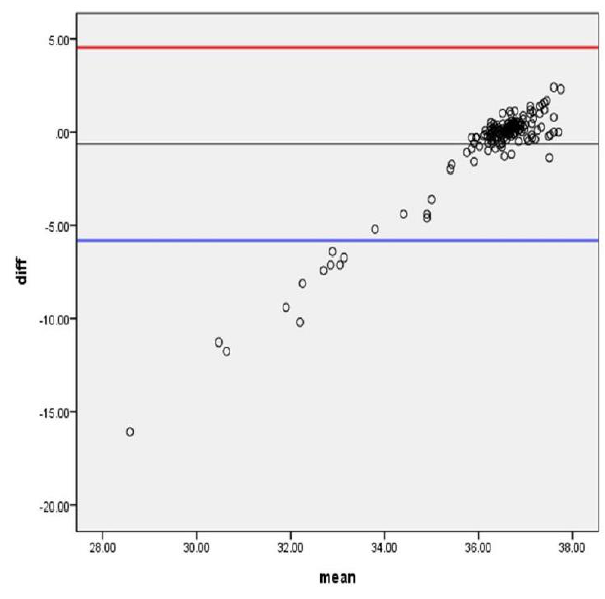
Figure 7. The Bland-Altman plot of mean differences.